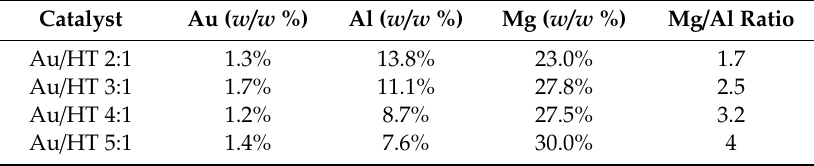
Table 1. ICP-OES analyses of the prepared catalysts.